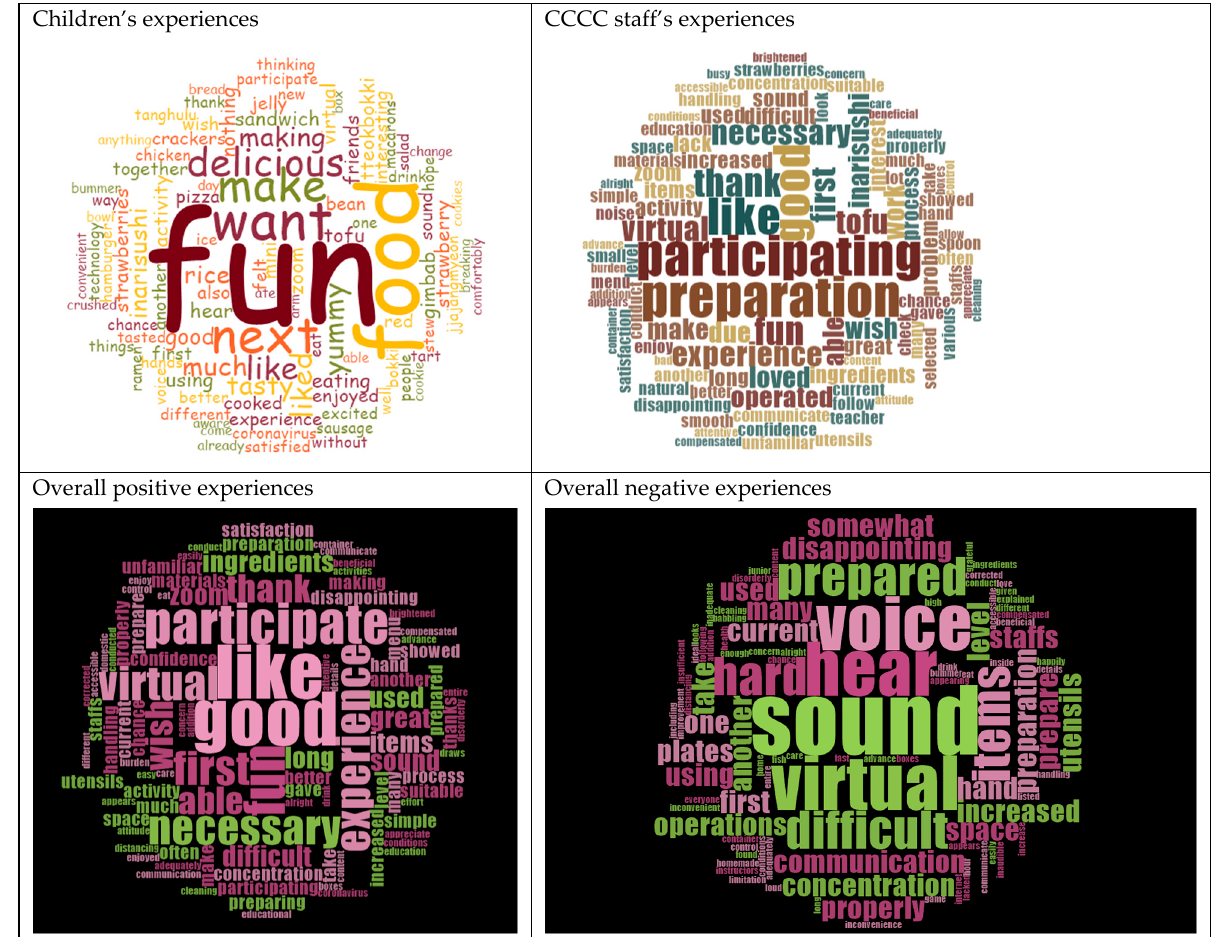
Figure 2. Word cloud analysis of the participants’ impressions and suggestions.